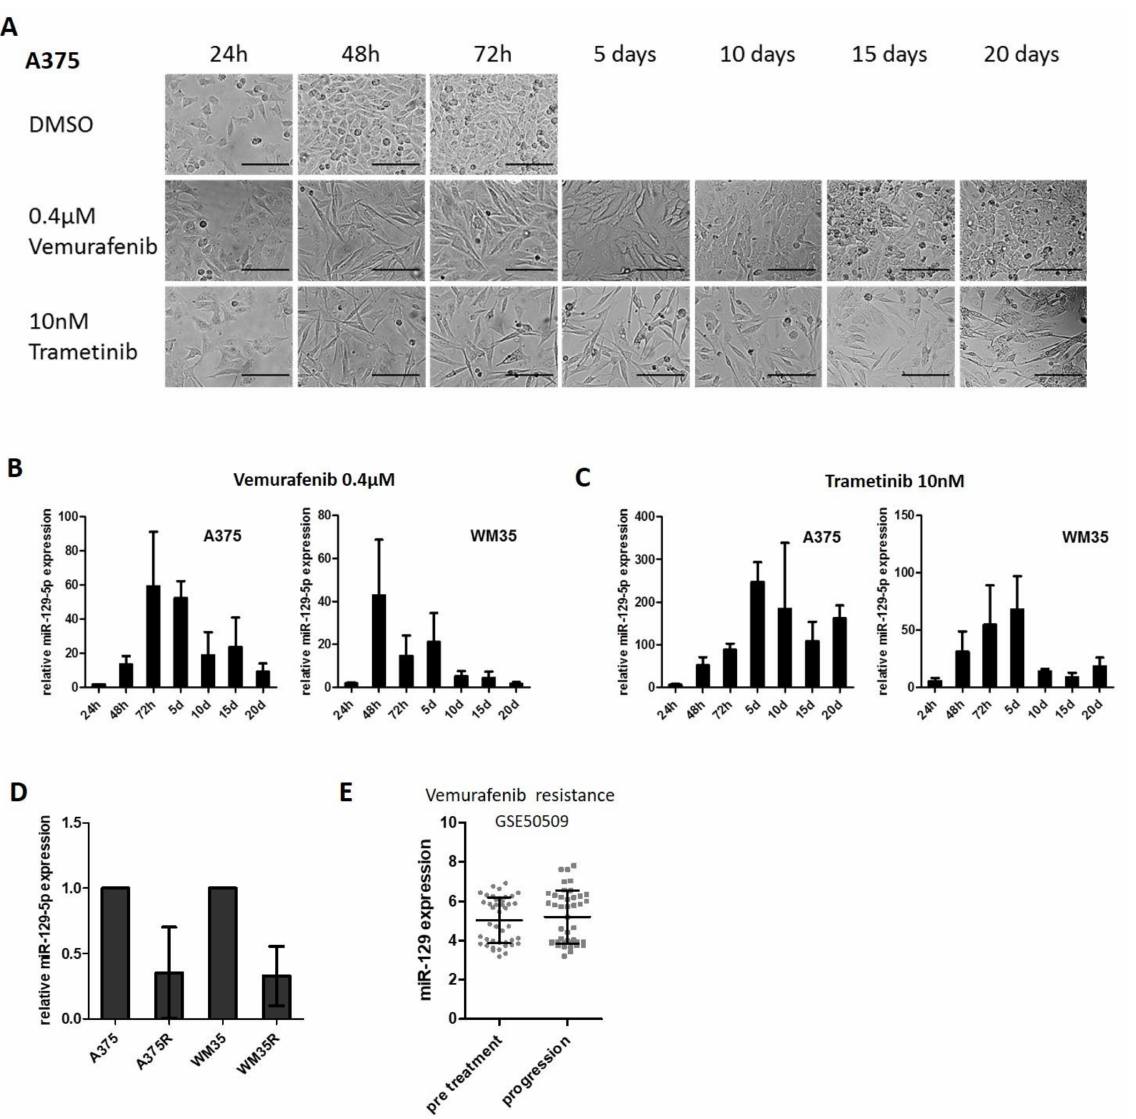
Figure 2. miR-129-5p expression decreases during emergence of resistance to BRAFi. ( A ) A375 cells were treated with Vemurafenib or Trametinib every second day for a period of 20 days. Images were taken at indicated time points. Scale bars represent 200 µ m. ( B , C ) Expression of miR-129-5p was analysed by qRT-PCR during permanent BRAF ( B ) or MEK ( C ) in- hibition over 20 days in two BRAF mutated melanoma cell lines (A375 and WM35). ( D ) qRT-PCR expression analyses of miR-129-5p in A375/WM35 compared to the corresponding BRAFi resistant cell line (A375R/WM35R). ( E ) Analysis of miR-129-5p expression in the data set GSE50509 comparing untreated melanoma samples and samples at tumor progression during BRAFi treatment. Bars represent average ± standard deviation of at least three independent